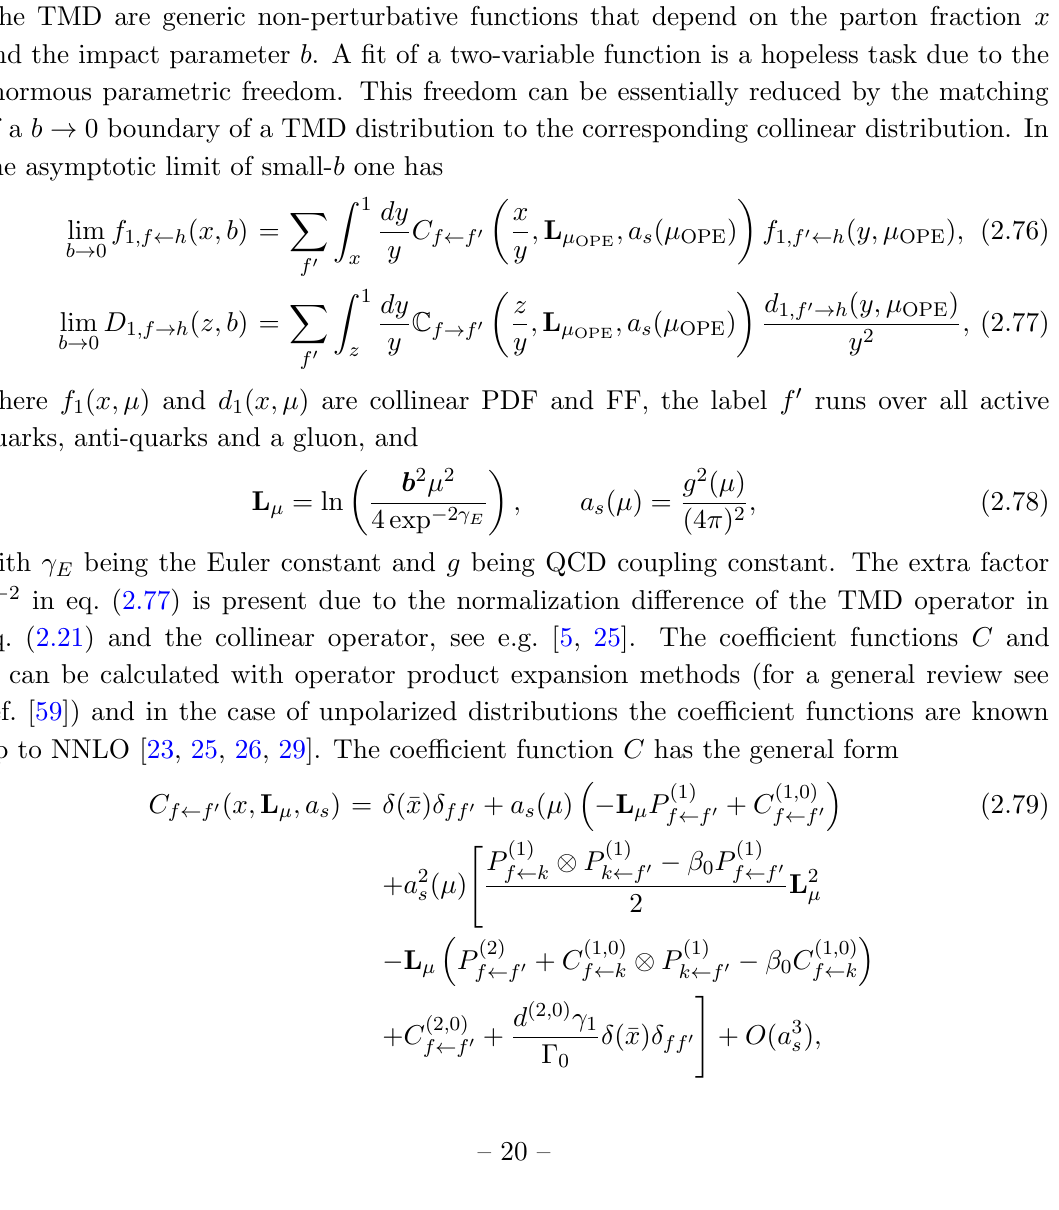
-order s -order of (cid:0) cusp s